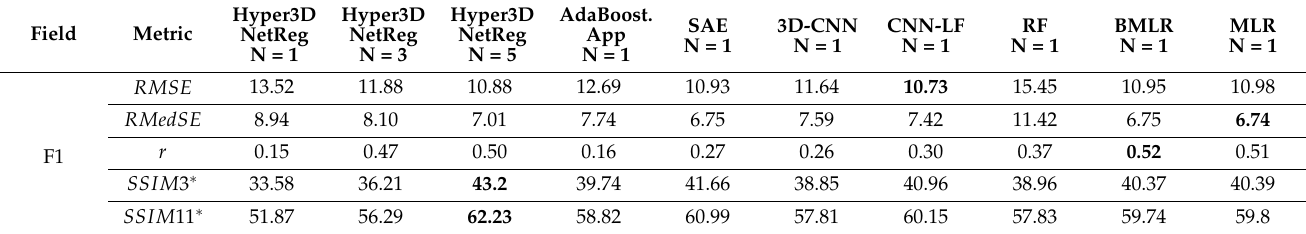
Table 4. Yield prediction comparison (split A). Best-performing metrics are highlighted in bold. SSIM 3 ∗ and SSIM 11 ∗ are SSIM values multiplied by